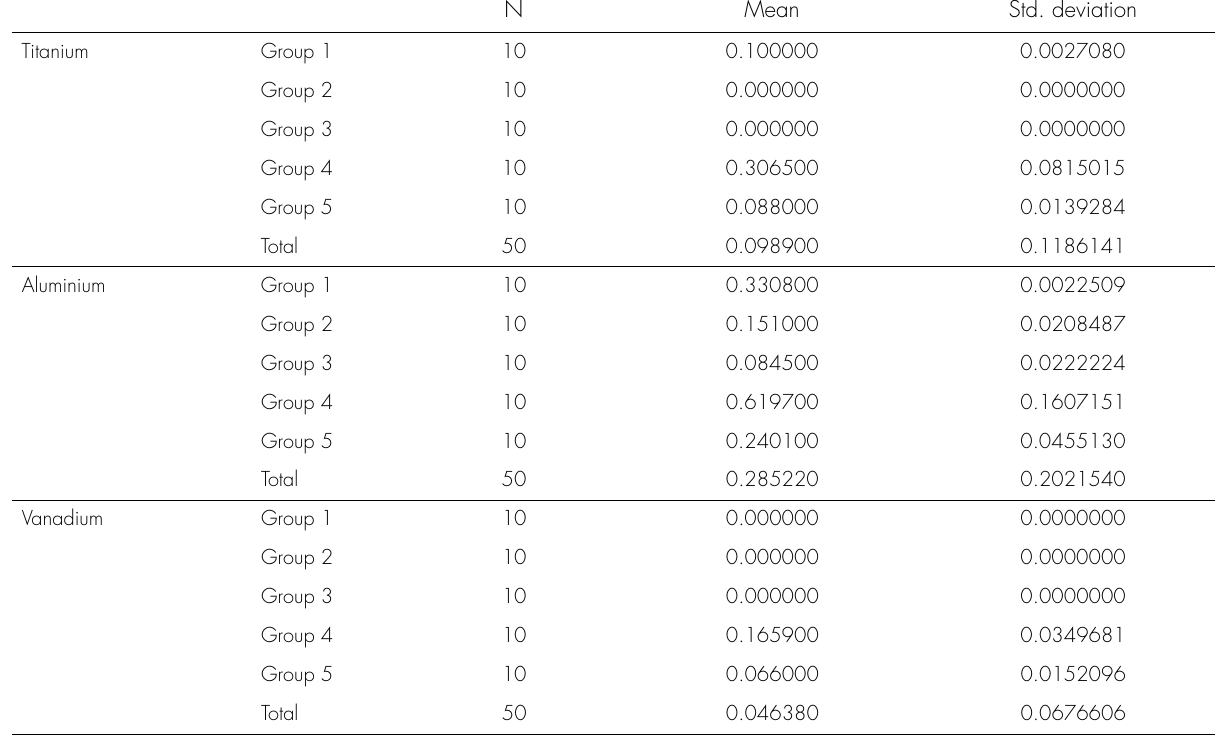
Table III. Descriptive statistics of Ti, Al and V release